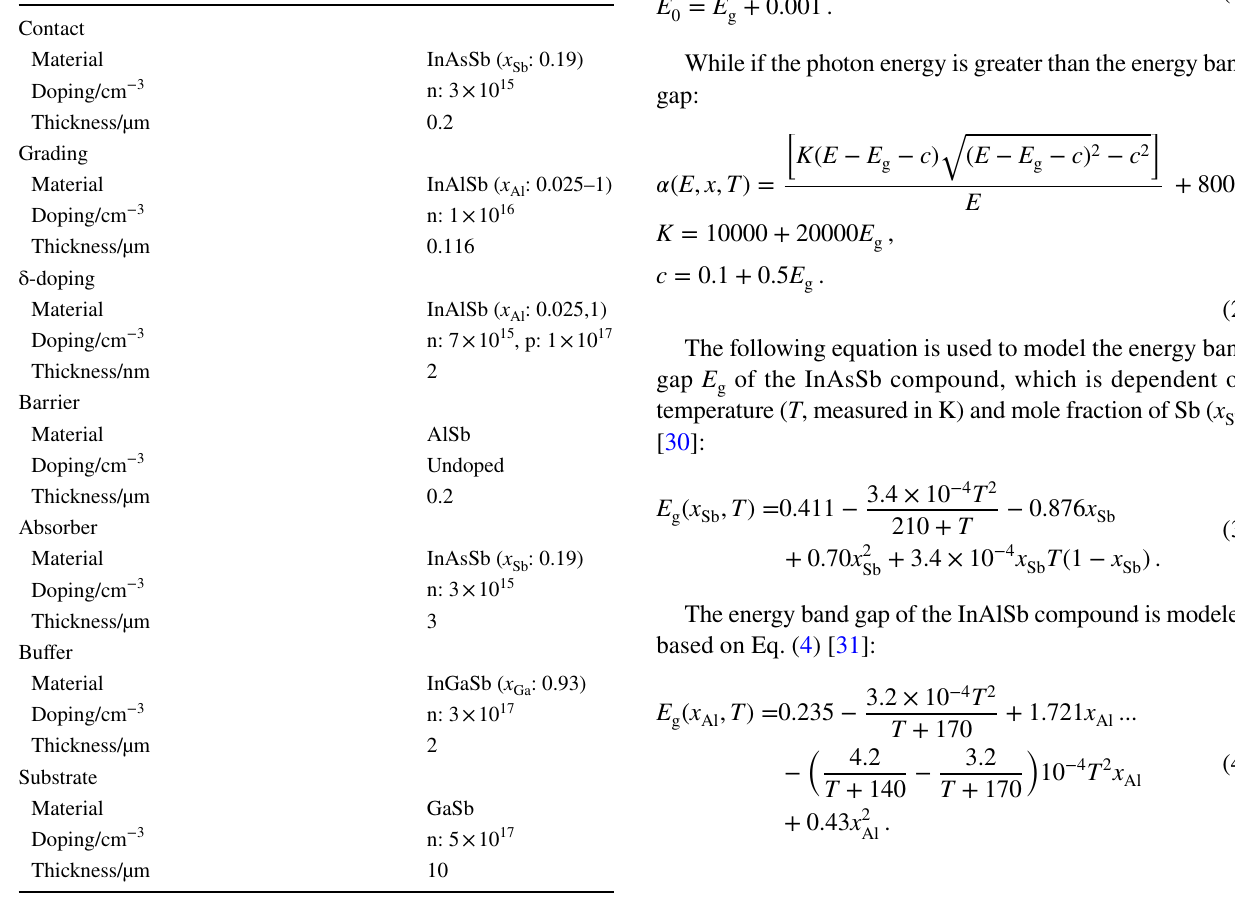
Table 1 Design parameters of the proposed nBn photodetector used in the simulation Layer nBn